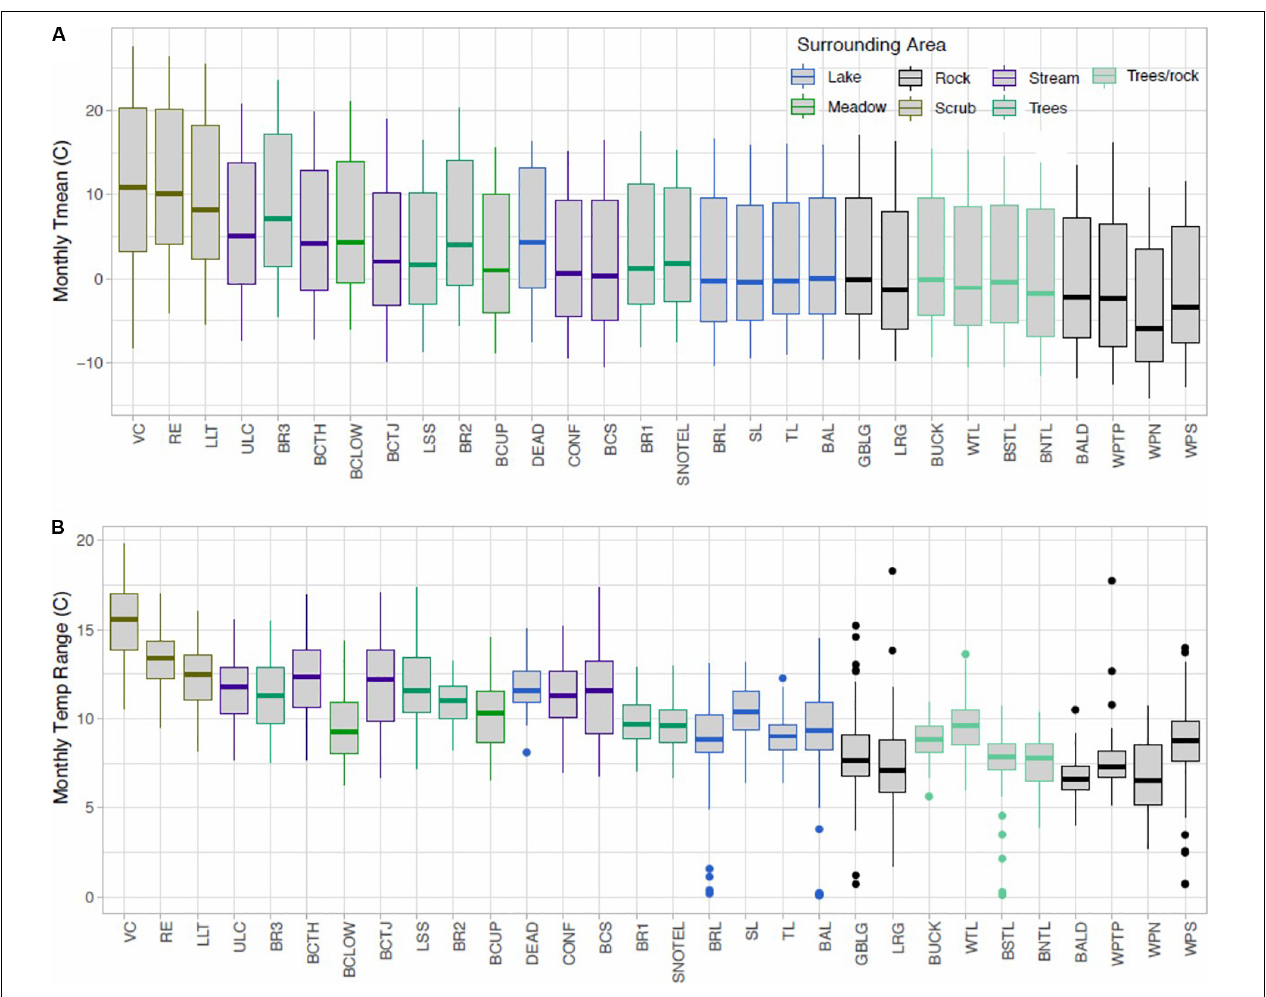
FIGURE 5 | Boxplots of monthly T mean ( A , top) and T range ( B , bottom) distributions for all the available Lascar sensors within the ESN, including data from 2006–2018. Colors describe the local environment surrounding each